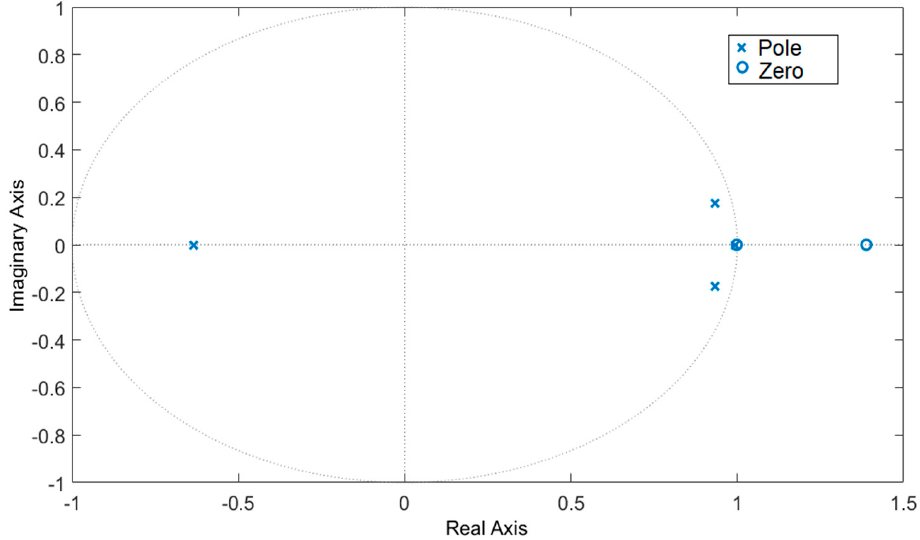
Figure 12. Pole-Zero plot for identified discrete model indicating a non-minimum phase system.